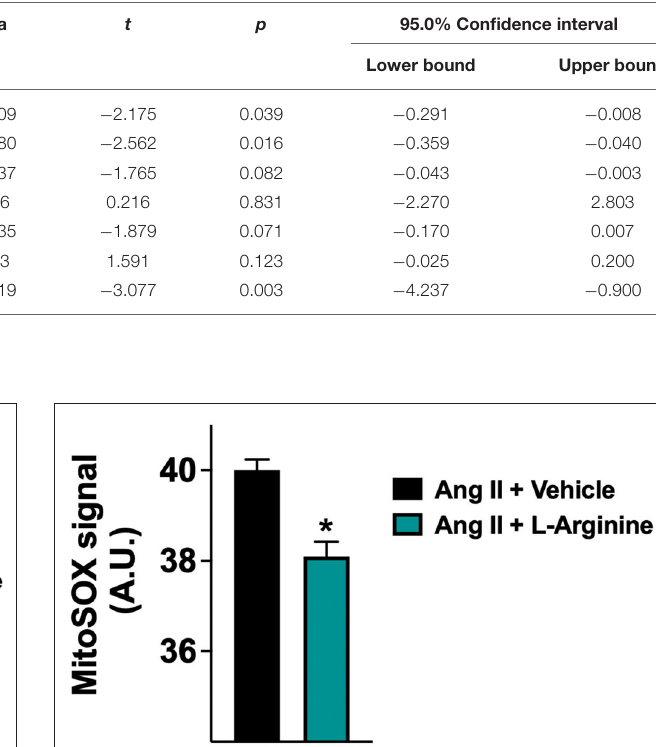
TABLE 2 | Multivariable linear regression analysis using the MoCA Score at follow-up as dependent variable.